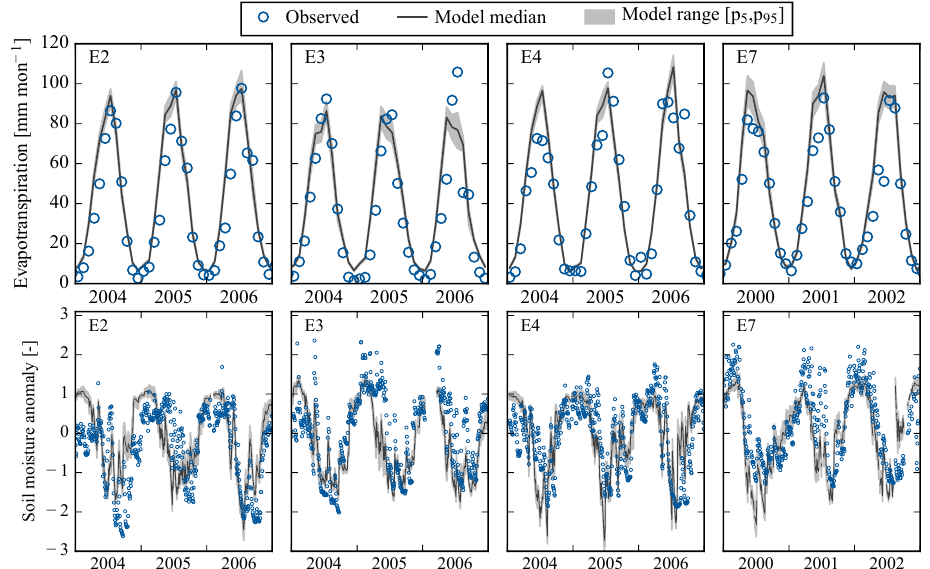
Figure 6. Exemplary time series of observed and modeled monthly evapotranspiration and daily soil moisture anomalies at four eddy covariance stations (Fig. 1, Table 2). The four stations are chosen because they represent the two major mHM land cover classes (forest and mixed) and have 3 consecutive years of data without significant data gaps. Further the four station are spread over the three regions where eddy covariance observations are available. The solid dark gray line depicts the median model results and the light gray band depicts the range between the 5th and 95th percentile of the 100 ensemble simulations.